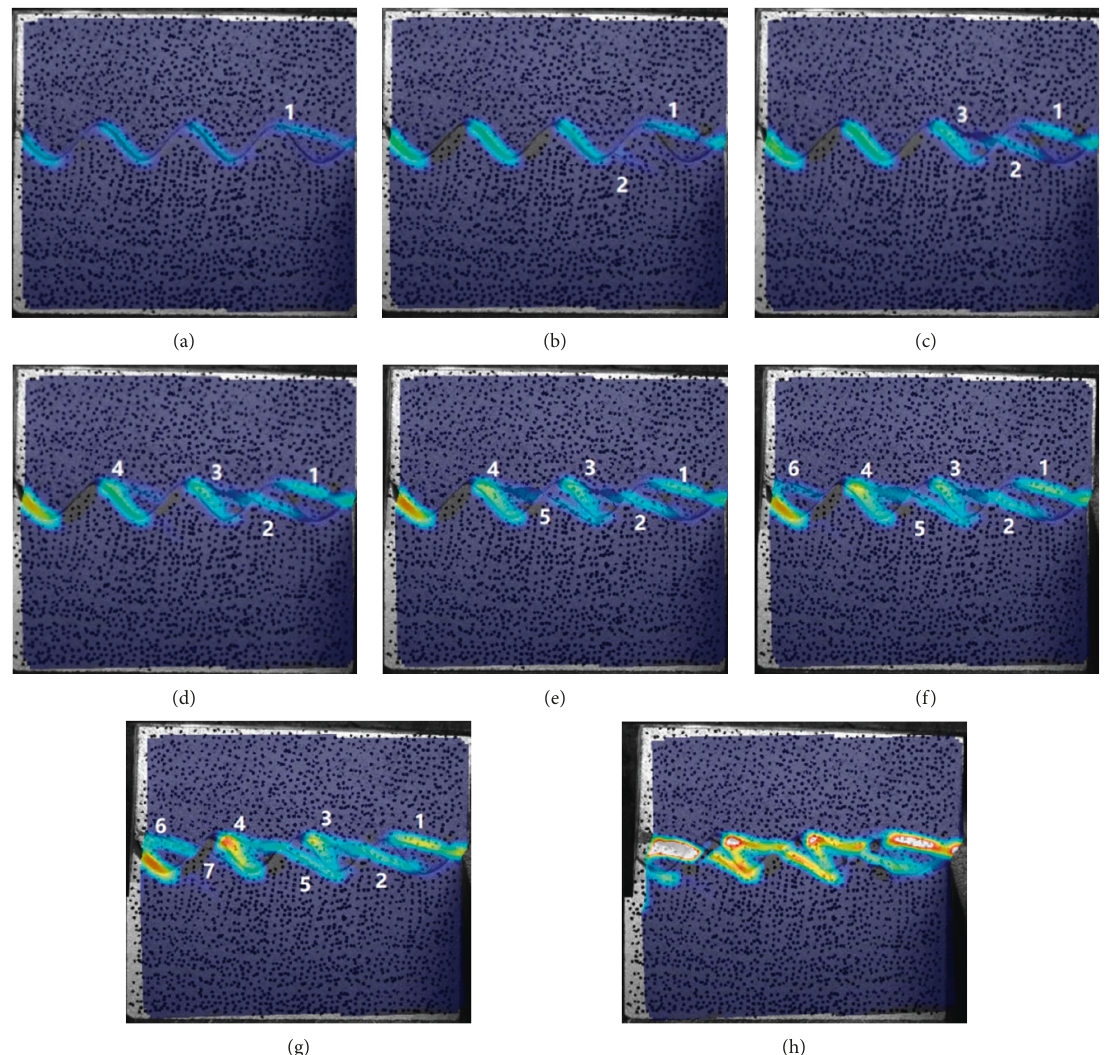
Figure 8: Failure process of the specimen with an undulated height of 10mm under DIC